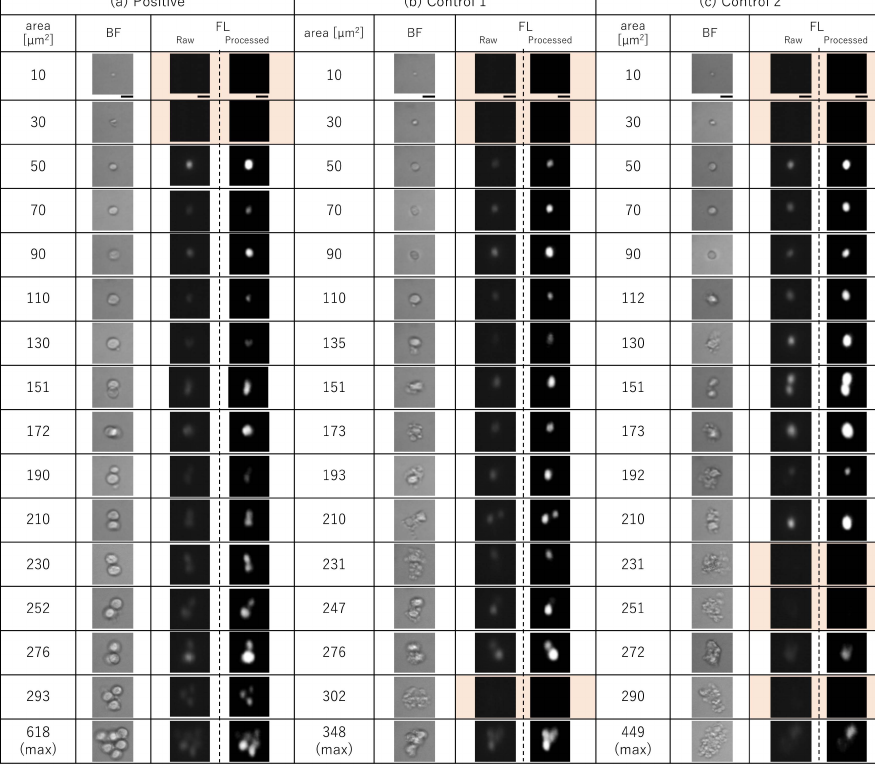
Figure 3. Typical cell images for positive ( a ), control 1 ( b ), and control 2 ( c ) blood having different BF cell areas at 20- µ m 2 intervals at 11 days after implantation. (left) BF; center, raw FL; and (right) processed FL images. Orange hatched frames in FL images, no nucleus in cells, that is, debris. Bars, 10 µ